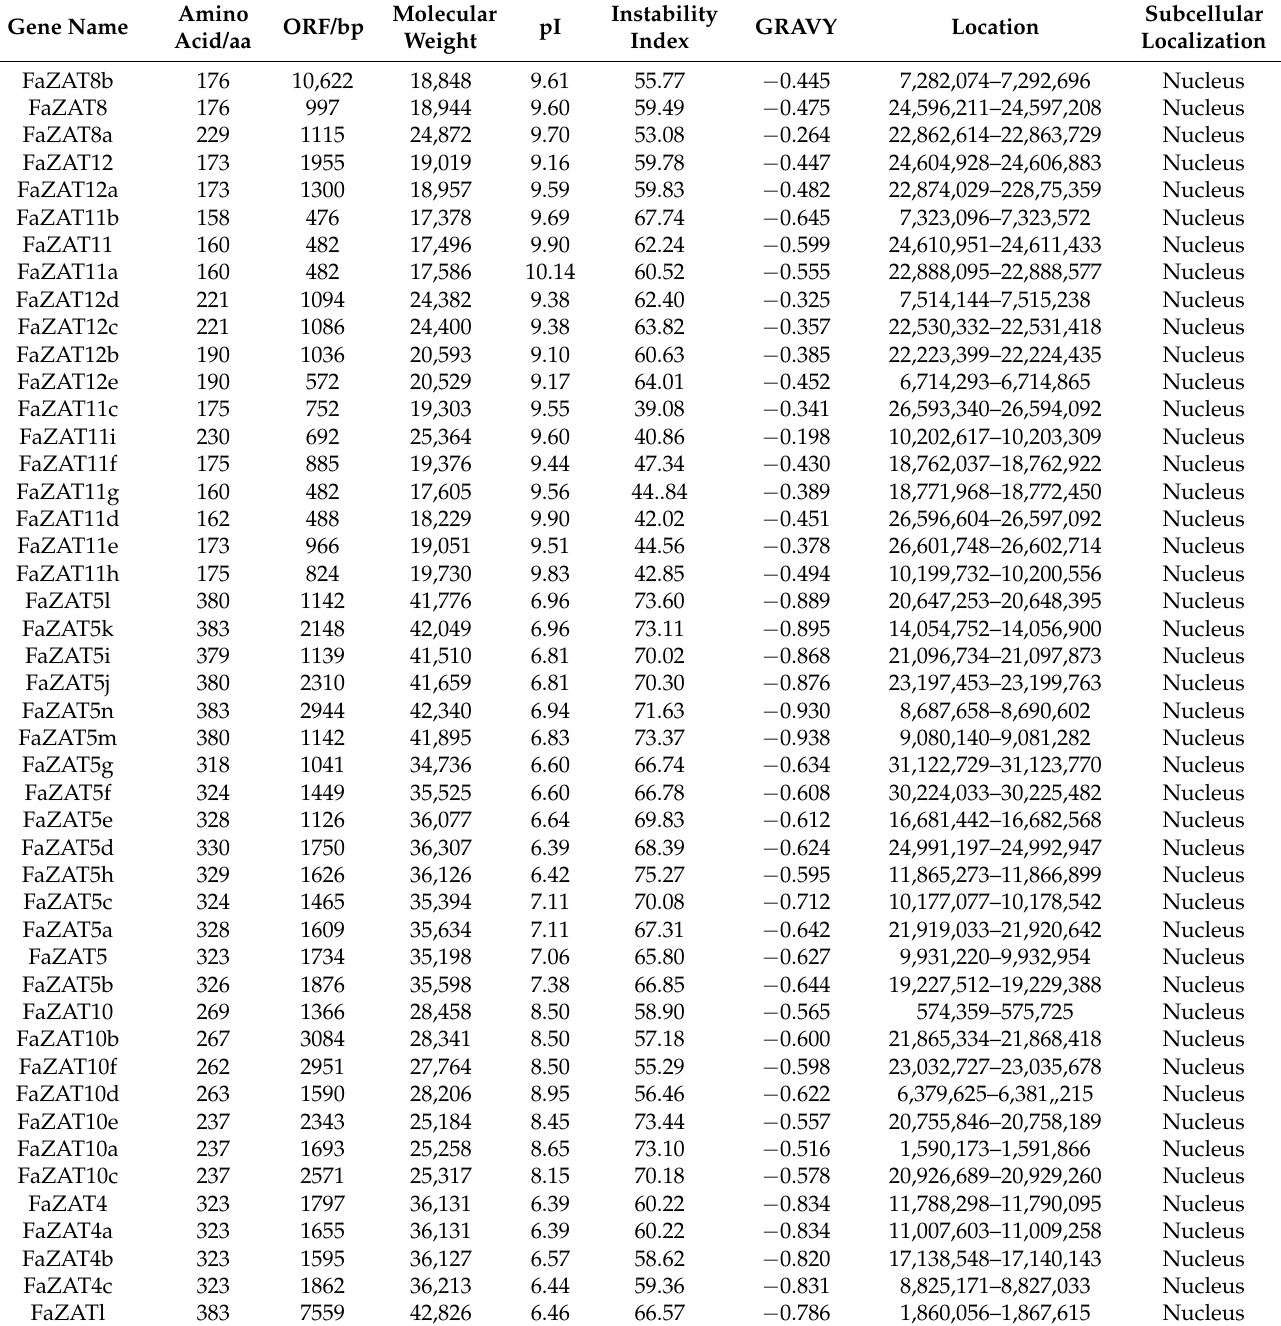
Table 1. The physical and chemical properties of C2H2-ZFP C1-2i proteins in F. × ananassa